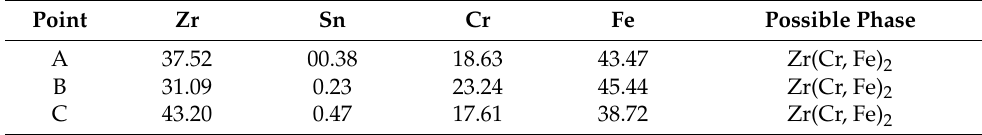
Table 1. Chemical composition and possible phase of each point marked in Figure 2d (at.